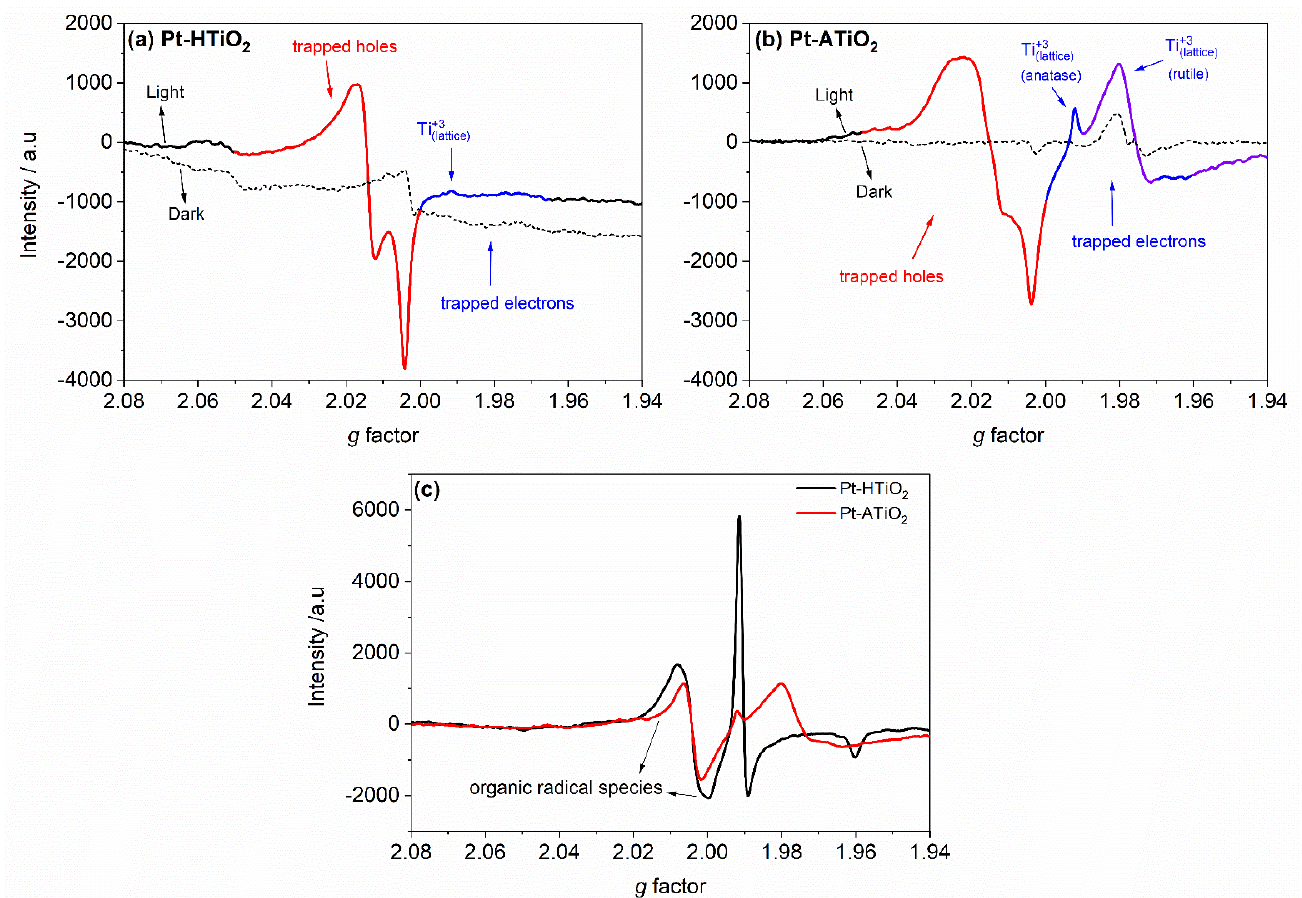
Figure 9. EPR spectra measured at 77 K in N 2 atmosphere for ( a ) 1.0 wt% Pt ‐ HTiO 2 , and ( b ) 1.0 wt% Pt ‐ ATiO 2 in dark (dash line) and light (solid line). ( c ) The photogenerated signals for 1.0 wt% Pt ‐ HTiO 2 (black line) and 1.0 wt% Pt ‐ ATiO 2 (red line) in the presence of N 2 ‐ naphthalene vapor under illumination.